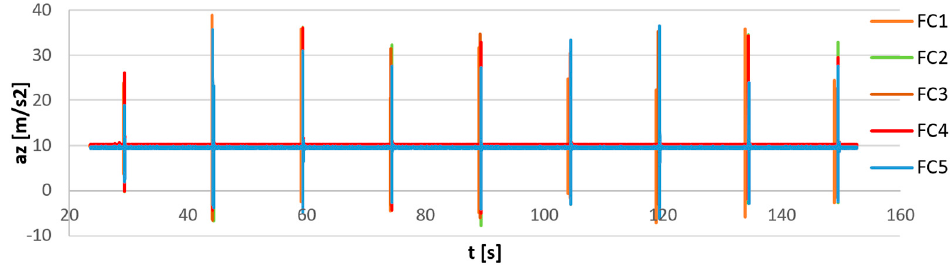
Figure 12. Raw measurement of impulse excitation (acceleration on the Z axis) of 5 flight controller sensors (FC1–FC5) before synchronization. sensors (FC1–FC5) before